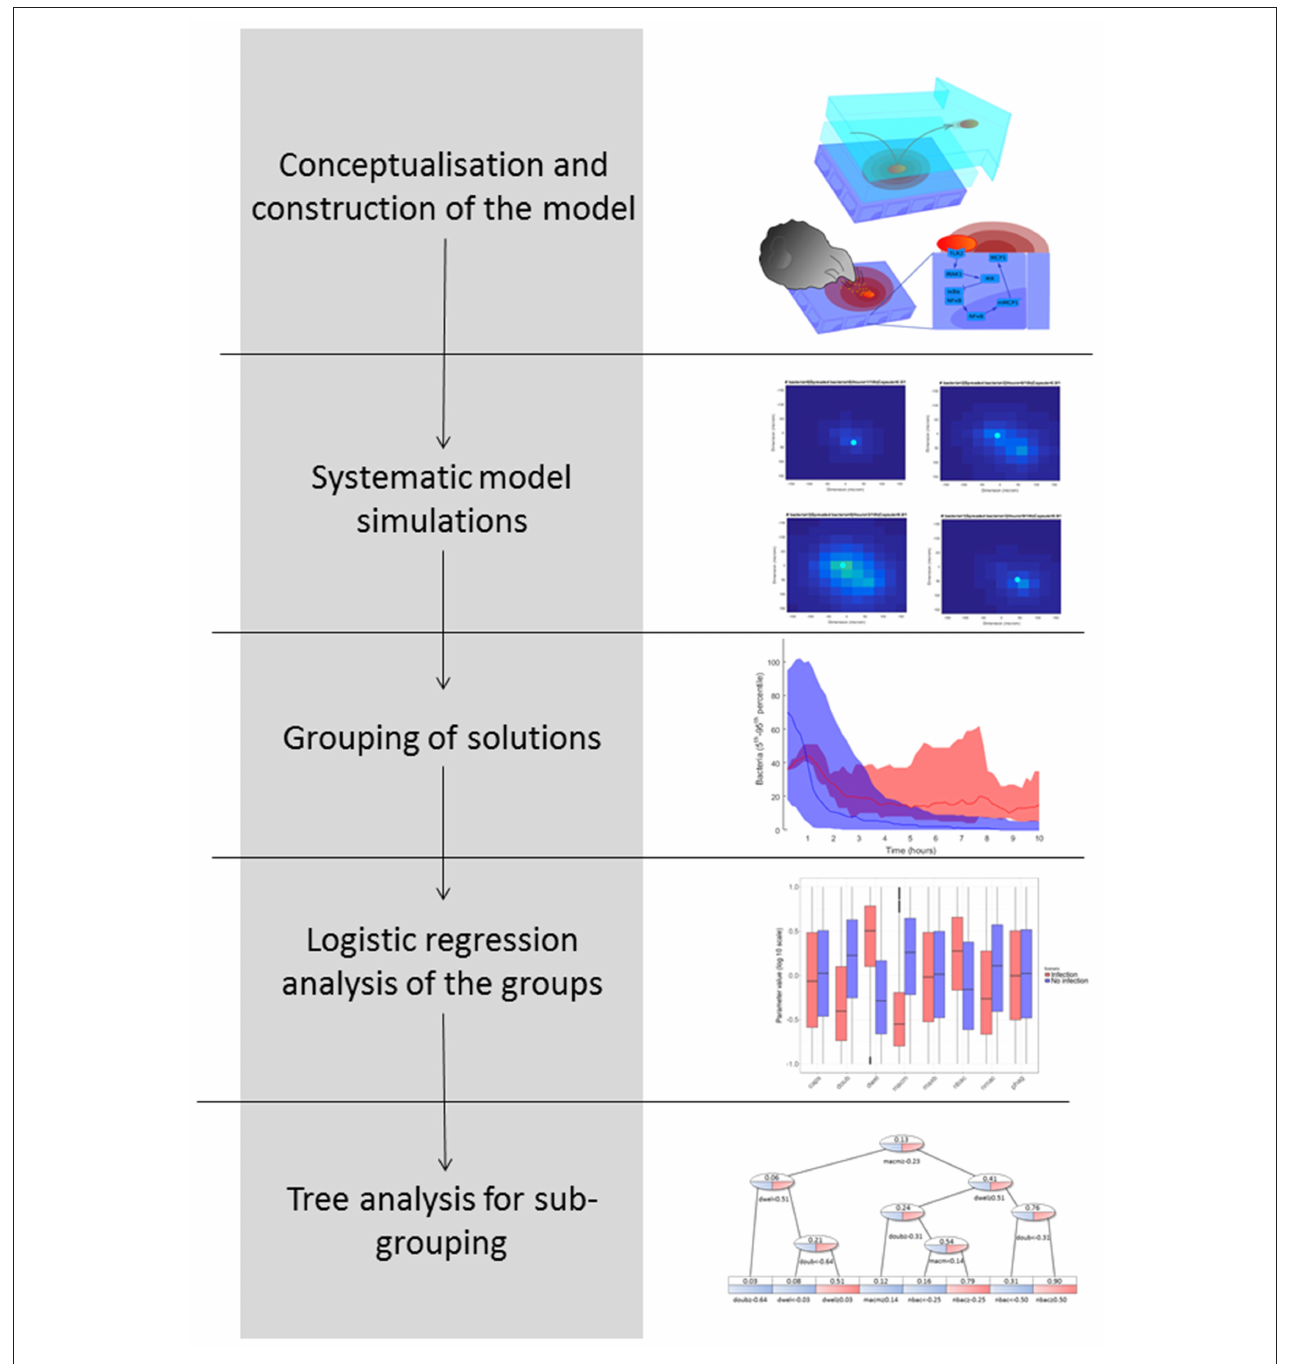
FIGURE 2 | Workflow of the study.